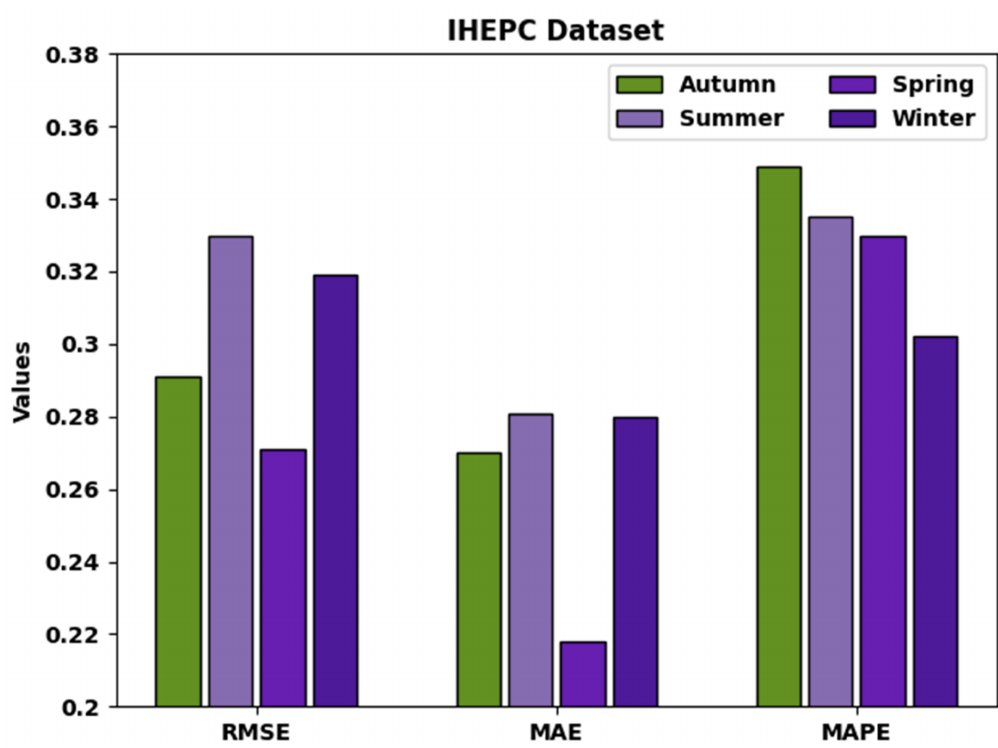
Figure 4. Result analysis of AJODL-DSSEM technique under IHEPC dataset.